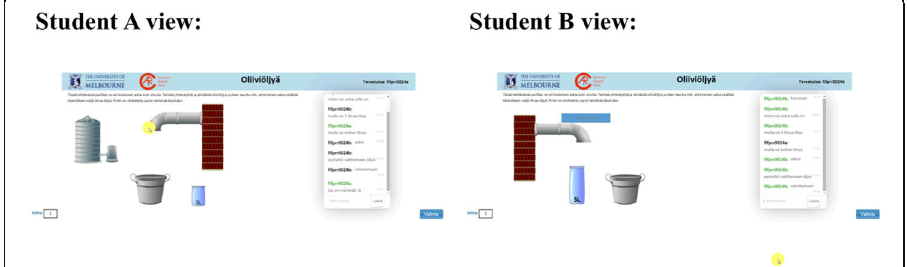
Fig. 3 A screen capture from the screen activity data (perspectives of students A and B, Olive